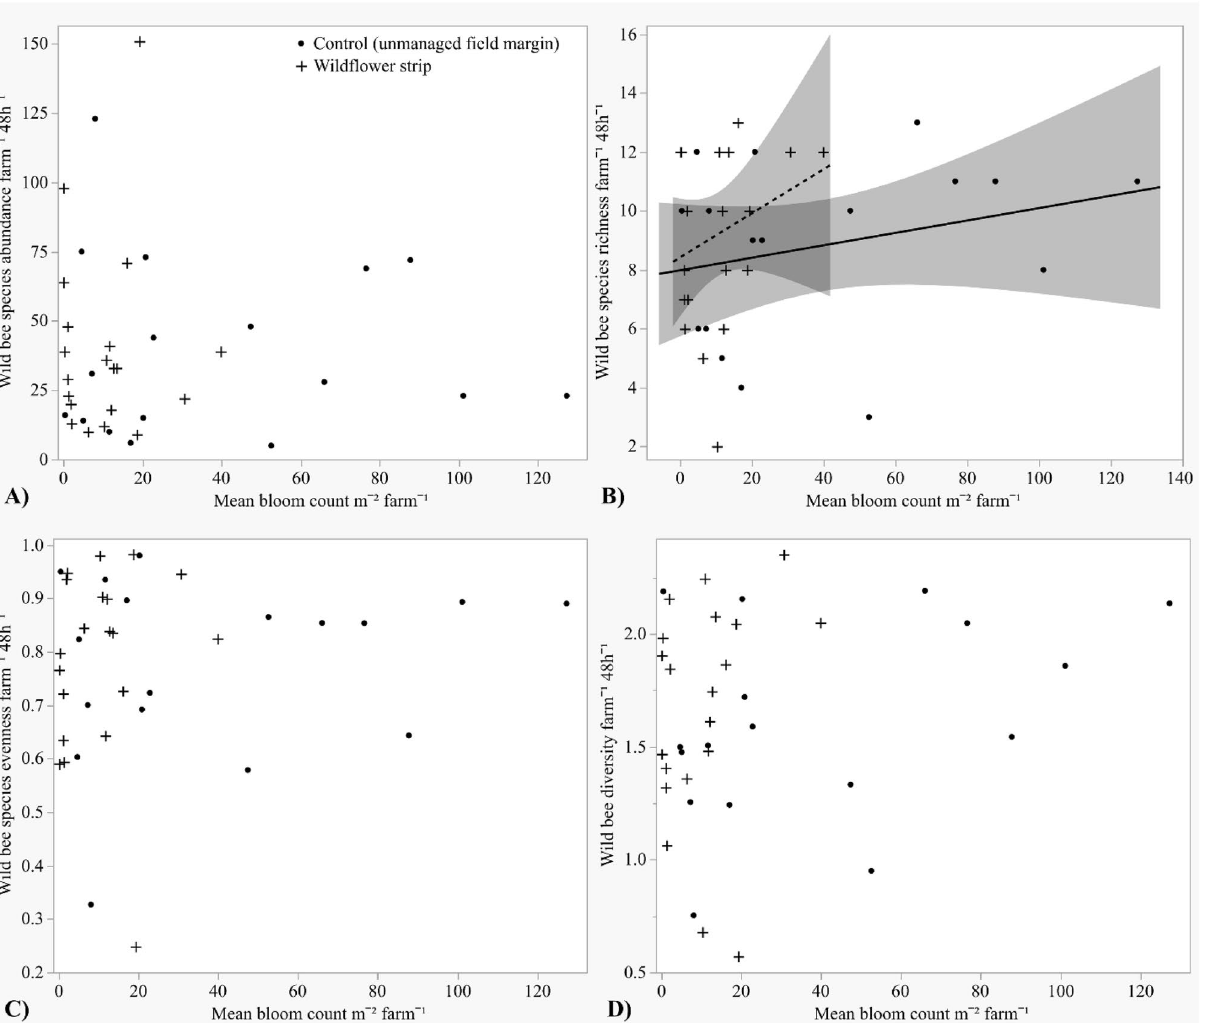
Figure 3. Mean total wild bee abundance, species richness, Shannon–Wiener diversity index, and species evenness (± SE) per farm by bloom density (mean bloom counts m −2 ) within wildflower strips or within unmanaged field margins on control farms. ( A ) Abundance, ( B ) Species richness, ( C ) Evenness, ( D )